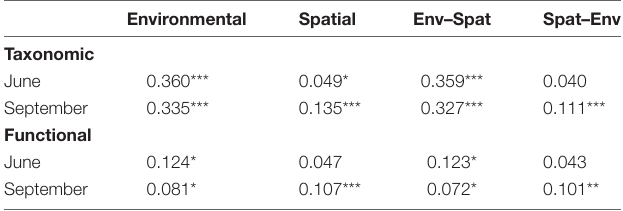
TABLE 2 | Results of the mantel and partial mantel tests for the relationships between taxonomic and functional community dissimilarity (Bray–Curtis) and environmental distance (Euclidean) and spatial distance for diatoms in rock pools ( n = 91).